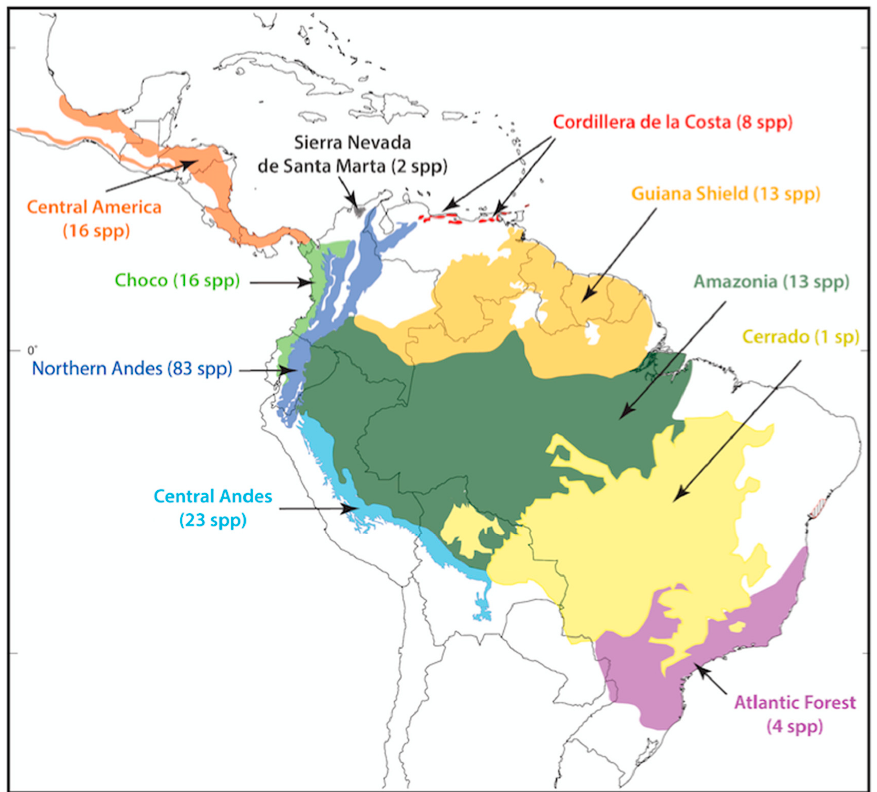
Figure 230. Biogeographical regions in the Neotropics (sensu Duellman [343]). Each region is followed by its number of glassfrog species. Note that one particular species can occur in more than one biogeographic area. Modified from Castroviejo-Fisher et al. [3].